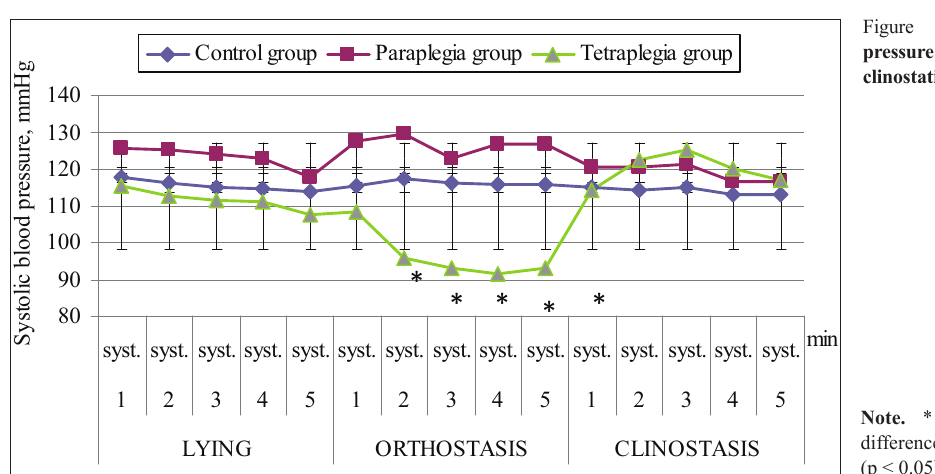
Note. * – statistically significant difference between all three groups (p < 0.05).